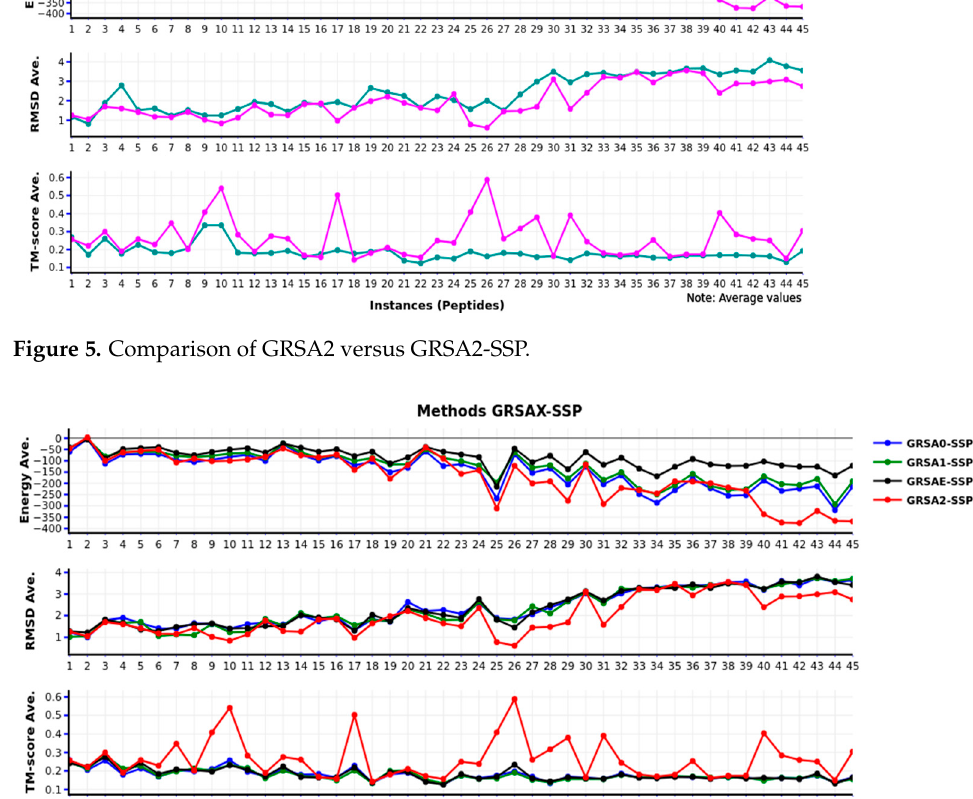
Figure 6. Comparison of GRSAX-SSP algorithms.